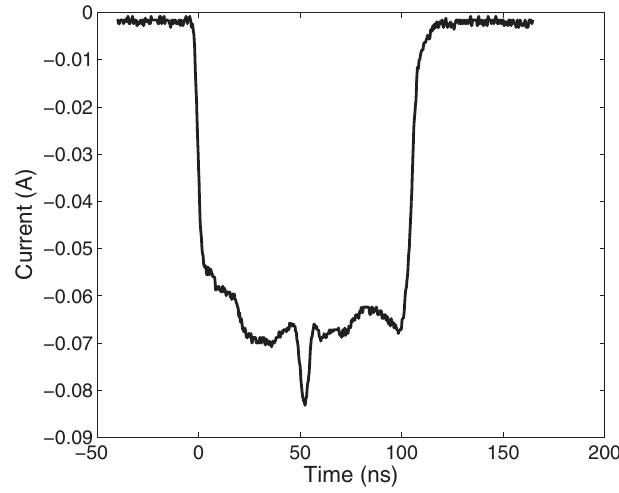
FIG. 4. Current profile imported into WARP in group